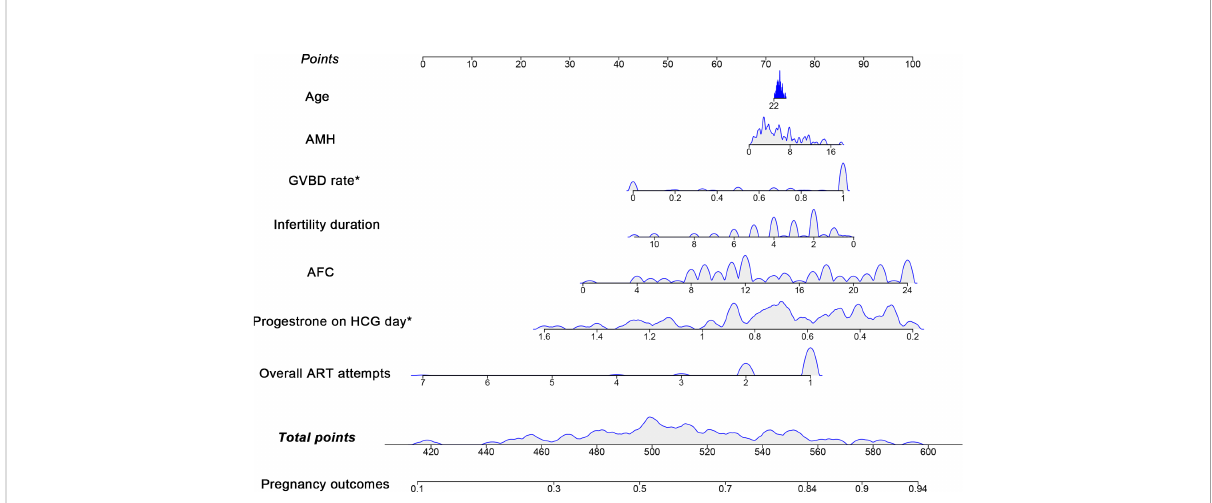
FIGURE 1 Nomogram with covariate distribution for predicting pregnancy using the multivariate logistic regression. The variables included in the nomogram were age, AMH, GVBD rate, infertility duration, AFC, progesterone on HCG day and overall ART attempts. Corresponding points were computed by drawing vertical lines from each variable axis upward to the point axis in the fi rst row. The total points were then summed up and marked downward to the probability of the pregnancy outcomes in the last row. The variables marked with “ * ” were factors associated with pregnancy outcomes in the